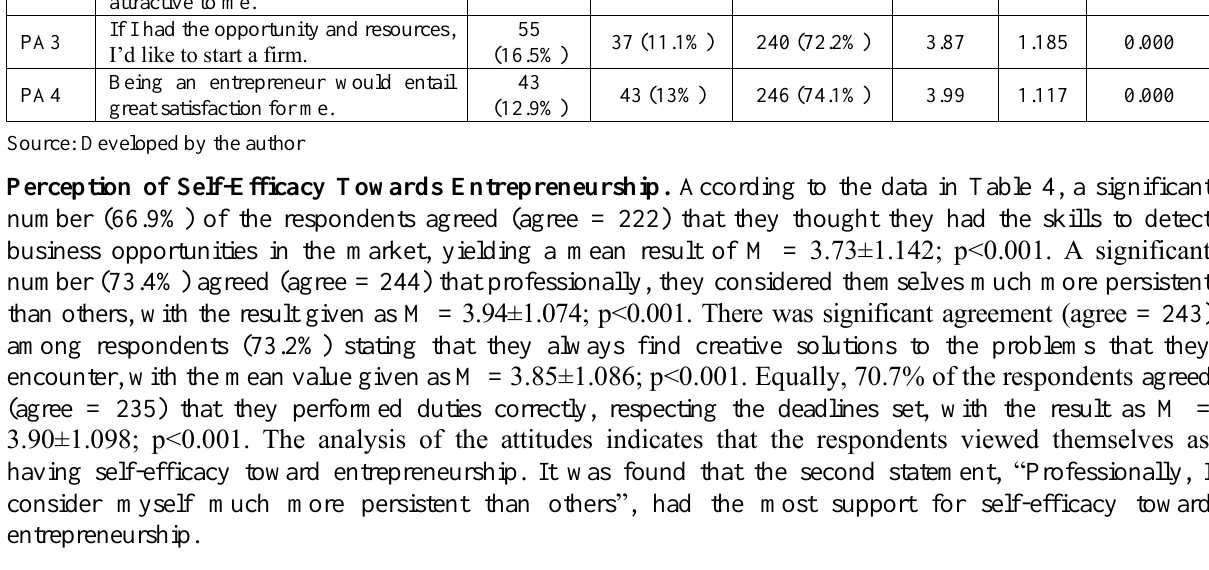
Table 4. Frequency Distribution of Perceived Self-Efficacy Towards Entrepreneurship